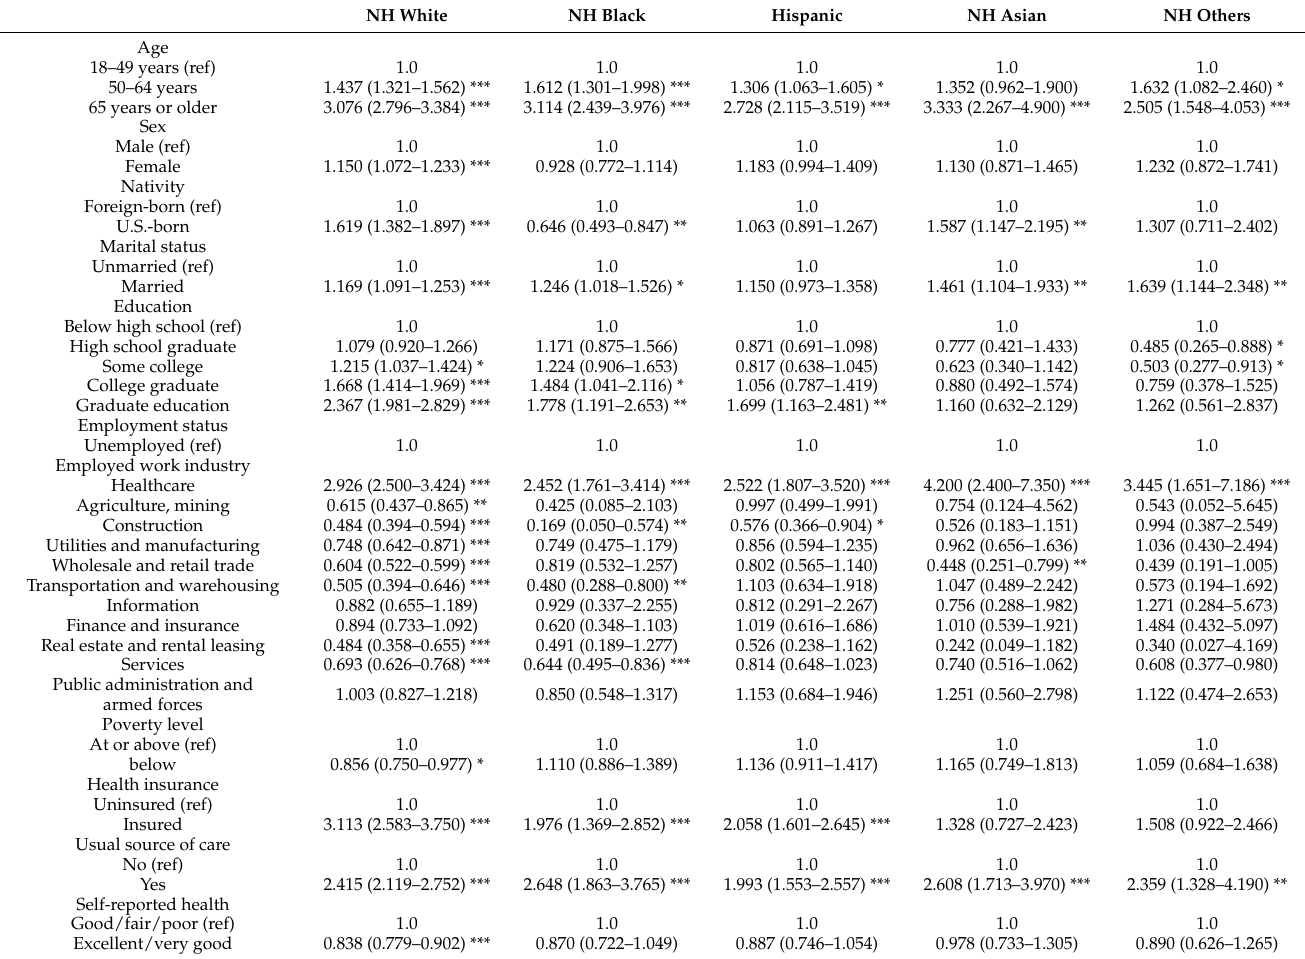
Table 3. Factors associated with influenza vaccine uptake by race and ethnicity. NH White NH